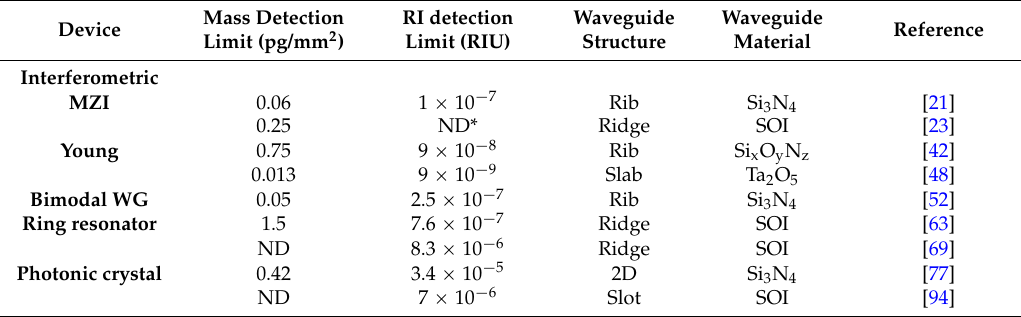
Table 1. Comparison of optical biosensors.